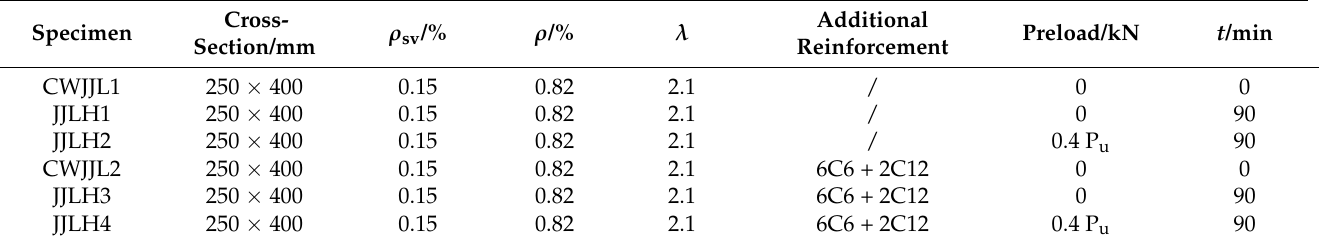
Table 1. Main parameters of the beams under indirect loading.